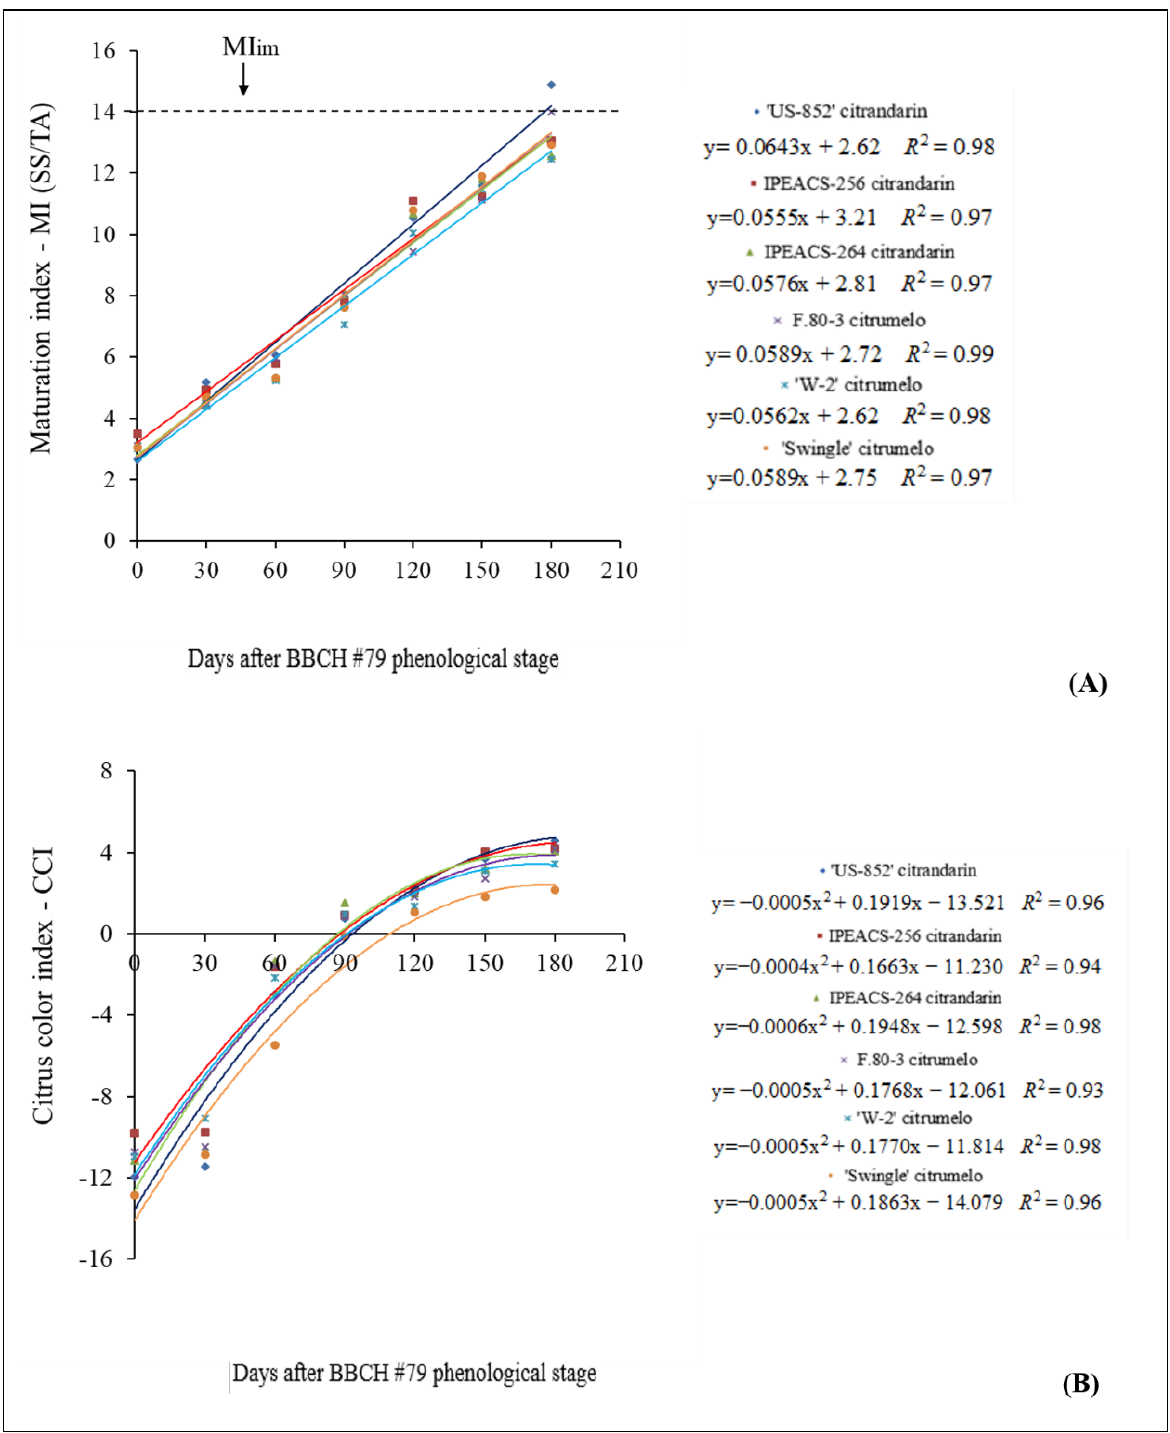
Figure 5. Development of ‘Valencia’ orange fruit ripening when trees are grafted on different ‘Trifoliata’ hybrid rootstocks at São Sebastião da Amoreira. ( A ): maturation index (MI) or ratio (SS/TA); ( B ): citrus color index (CCI). MI im = ideal mean maturation index = 14. Phenological stage BBCH #79 (Meier, 2001), approximately to 200 days after flowering.